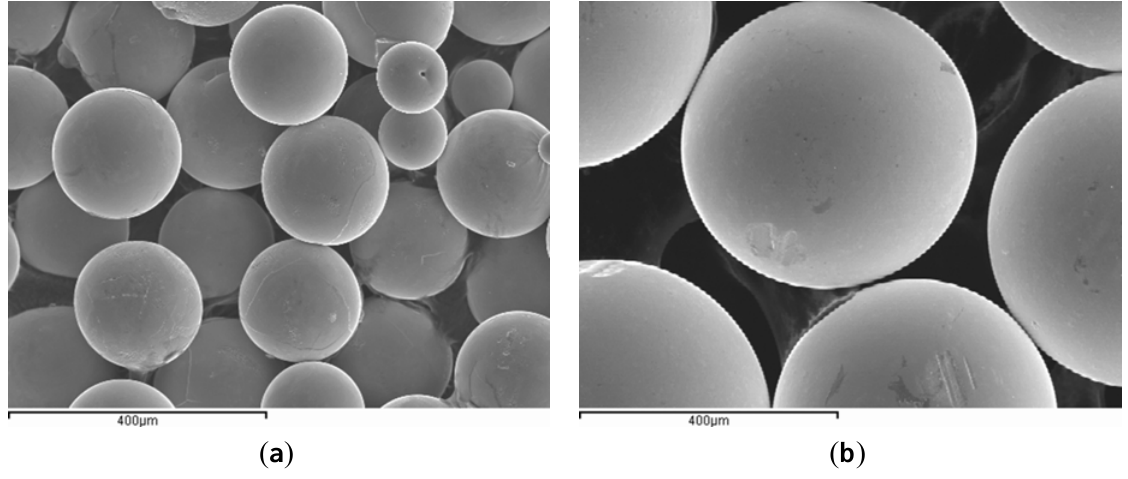
Figure 1. Morphology of the Ti–6Al–4V spherical powder produced by the plasma-rotating electrode process (PREP): ( a ) Fine particles ( − 250/+180 µm); ( b ) Coarse particles ( − 600/+425